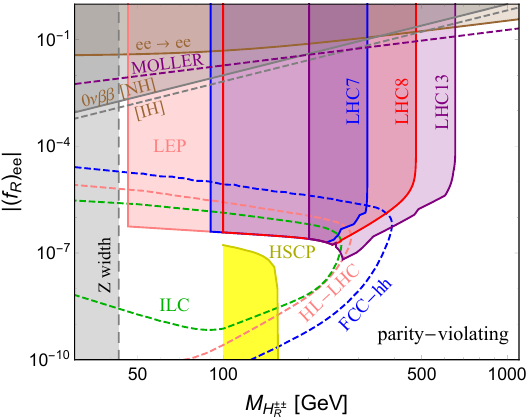
Figure 25 . Summary of the most important constraints and sensitivities on M and the Yukawa H (cid:6)(cid:6) R coupling j ( f R ) ee j in the parity-violating LRSM, extracted from 21, 22, 23 and 24. The DV prospects at ILC 1 TeV with a luminosity of 1 ab (cid:0) 1 (dashed green), HL-LHC 14 TeV with 3000 fb (cid:0) 1 (dashed pink) and FCC-hh 100 TeV with 30 ab (cid:0) 1 (dashed blue) are shown assuming at least 100 signal events. All the shaded regions are excluded, which are derived from the e + e (cid:0) ! e + e (cid:0) limit from LEP (orange), the 0 (cid:23)(cid:12)(cid:12) constraints for NH (brown) and IH (dashed brown) neutrino spectra, the MOLLER prospect (dashed purple), limit on M from Z boson width (gray), the dilepton H (cid:6)(cid:6) R constraints from LEP (pink), LHC 7 TeV (blue), 8 TeV (red) and 13 TeV (purple), and the CMS HSCP limit (bright yellow). For all the dilepton limits at LEP and LHC, we have left out the regions with c(cid:28) 0 ( H (cid:6)(cid:6) ) > 0 : 1 mm (cf. (cid:12)gure 21). R in the parity-violating LRSM at future HL-LHC (dashed pink), ILC (dashed green) and FCC-hh (dashed blue) are largely complementary to the prompt e (cid:6) e (cid:6) limits from LEP (pink) and LHC (blue, red and purple) and the CMS HSCP data (bright yellow), as well as to the low-energy constraints from the LEP e + e (cid:0) ! e + e (cid:0) data (brown) and 0 (cid:23)(cid:12)(cid:12) (solid and dashed gray). As in (cid:12)gure 20, we have spared the regions with c(cid:28) ( H (cid:6)(cid:6) ) > 0 : 1 0 L